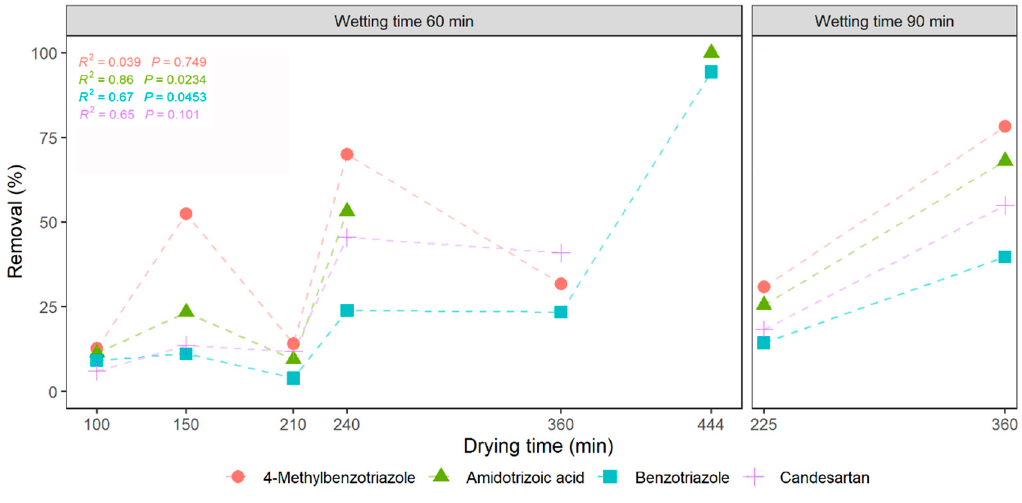
Figure 7. Removal e ffi ciency (%) of 4-methylbenzotriazole, amidotrizoic acid, benzotriazole and Figure 7. Removal efficiency (%) of 4-methylbenzotriazole, amidotrizoic acid, benzotriazole and candesartan under di ff erent HLCs. Not all substances were measured for all scenarios. Significance of candesartan under different HLCs. Not all substances were measured for all scenarios. Significance trends is indicated by coe ffi cient of determination (R 2 ) and probability in statistical significance (P). of trends is indicated by coefficient of determination (R 2 ) and probability in statistical significance (P). Values below DL were regarded with DL / Values below DL were regarded with DL/2.